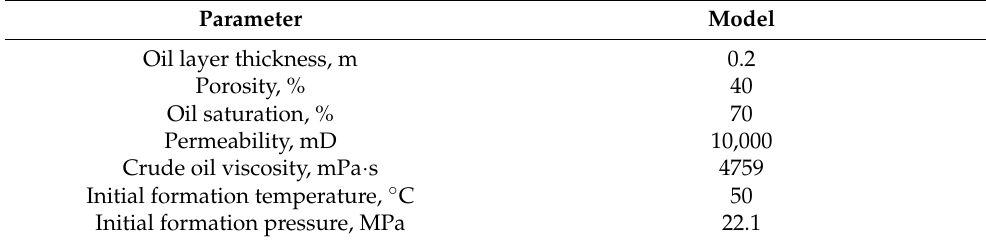
Table 3. Parameters of three-dimensional physical model.